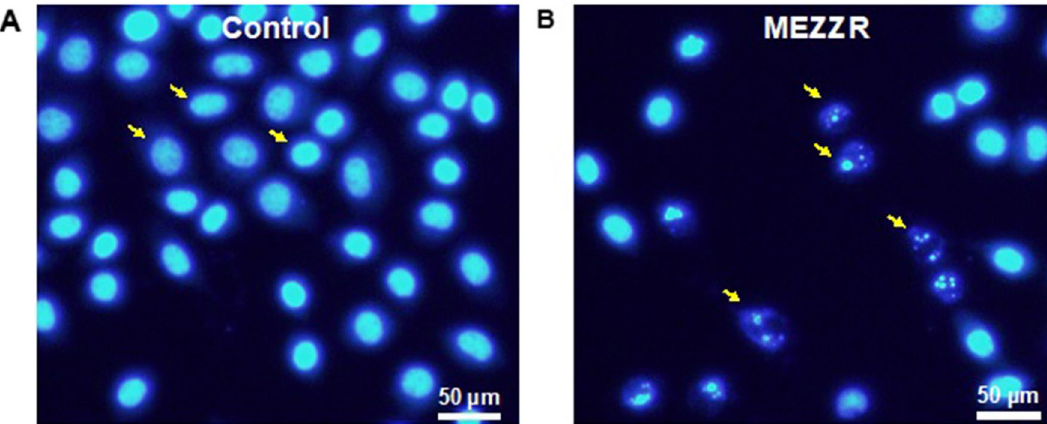
Figure 4. MEZZR triggers apoptosis in EAC cells. EAC cells collected from the treated and non-treated EAC bearing mice were stained with Hoechst 33342 and then cell morphology was observed by a fluorescence microscope. The left panel ( A ) indicates control, and the right panel ( B ) indicates MEZZR (20 mg/kg/day) treatment. Note that apoptotic characteristics, nuclear condensation and fragmentation are shown in ( B